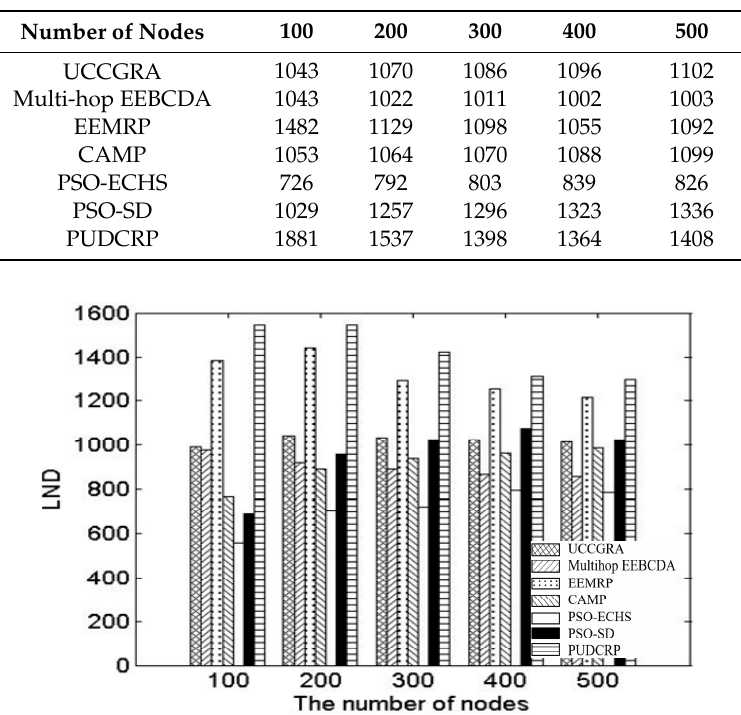
Figure 19. The nodes number scalability of the nodes number in 400 m × 400 m network area.